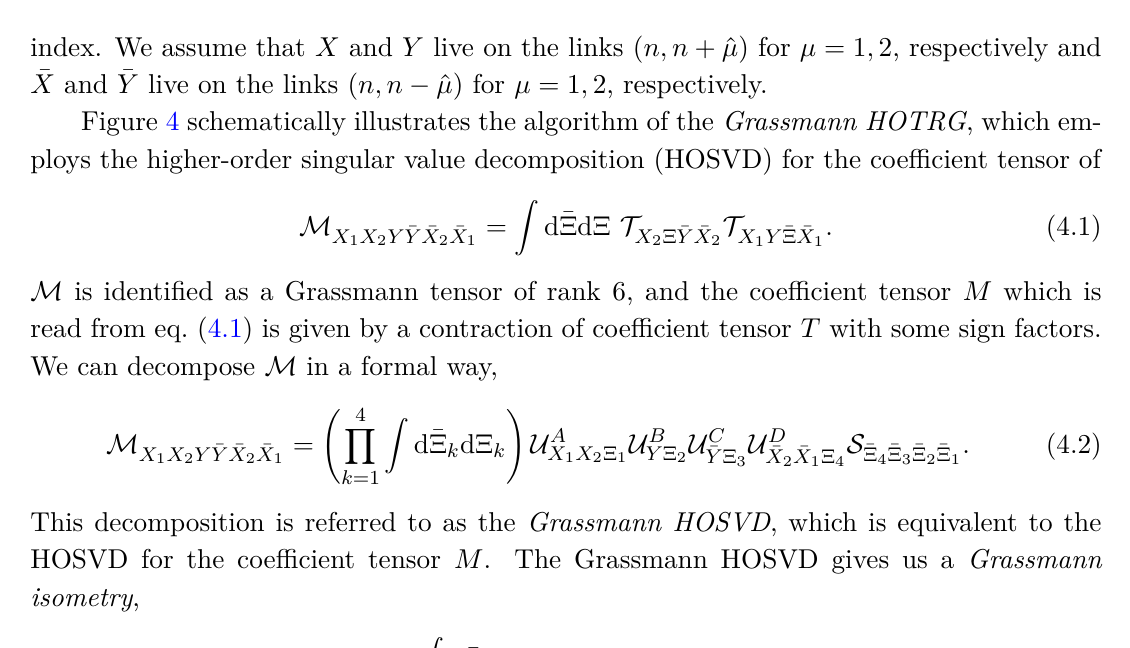
Figure 4 . Schematic picture of the Grassmann HOTRG. (A) Grassmann tensor network in two dimensions. (B) Grassmann isometries are inserted in the whole network. (C) Tensor network is renormalized so that the lattice size is reduced by a factor of